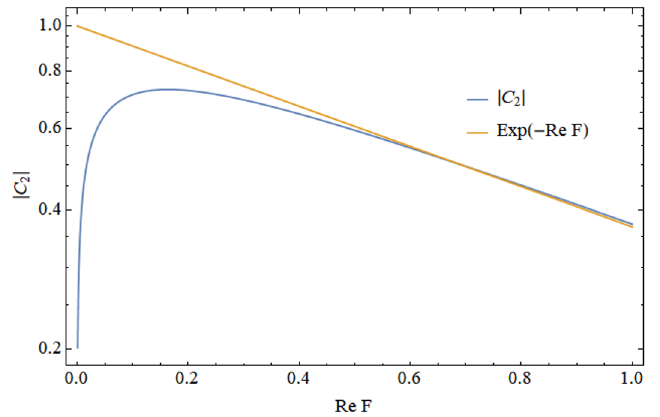
Figure 4 . The comparison between | C 2 | and e − Re F with 0 < Re F ≤ 1 , and the vertical axis is in logarithmic